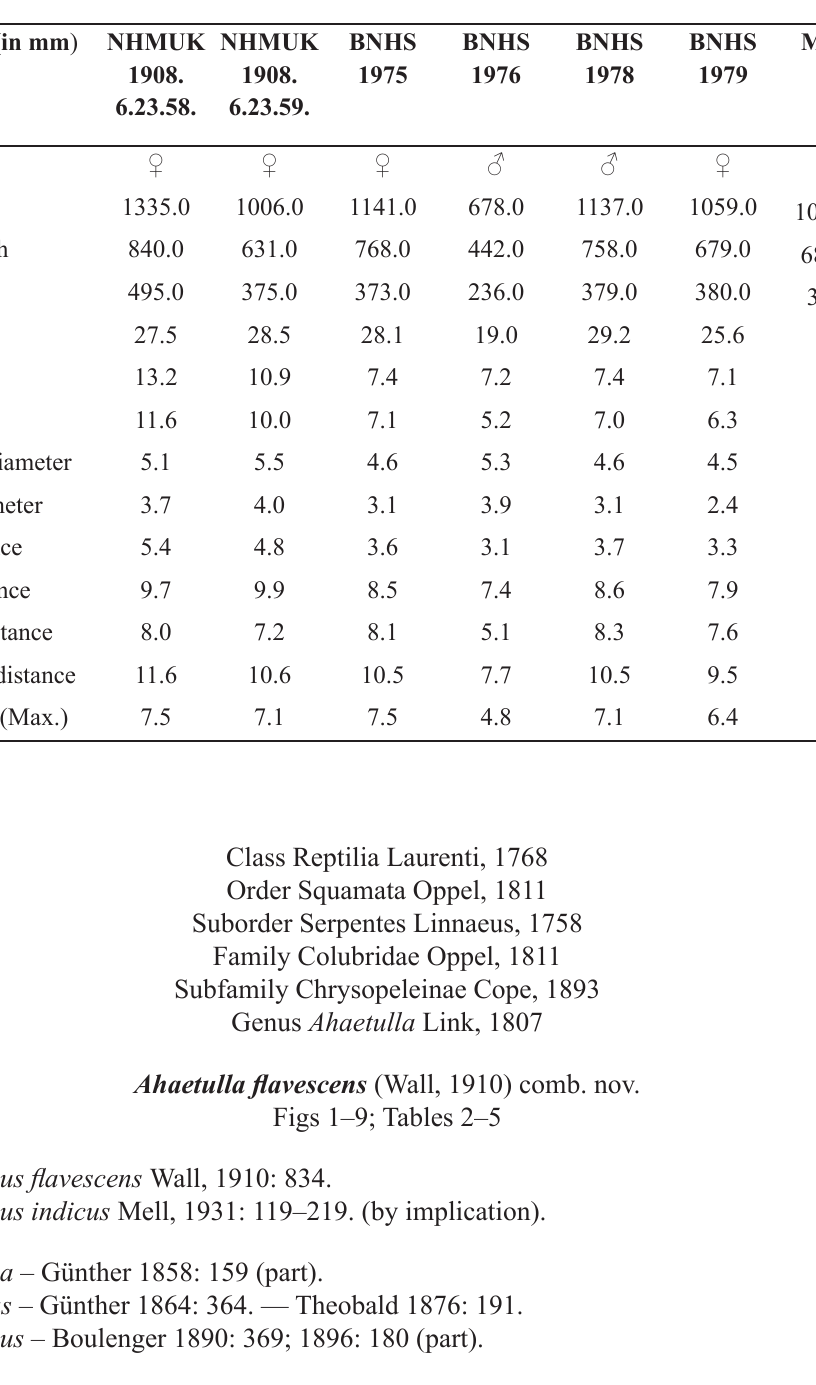
Table 4. Main morphological characters of the type and referred materials of Ahaetulla flavescens (Wall, 1910) comb.